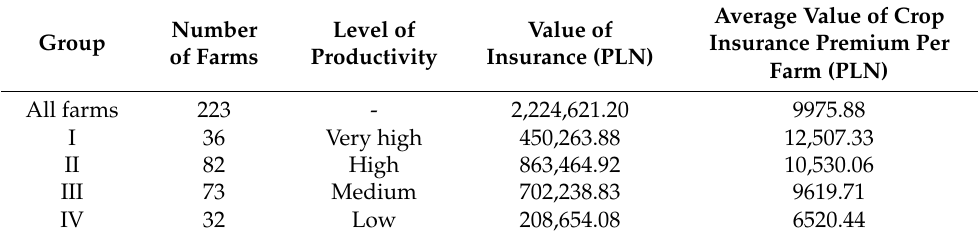
Table 8. The level of land productivity and the average cost of crop insurance.